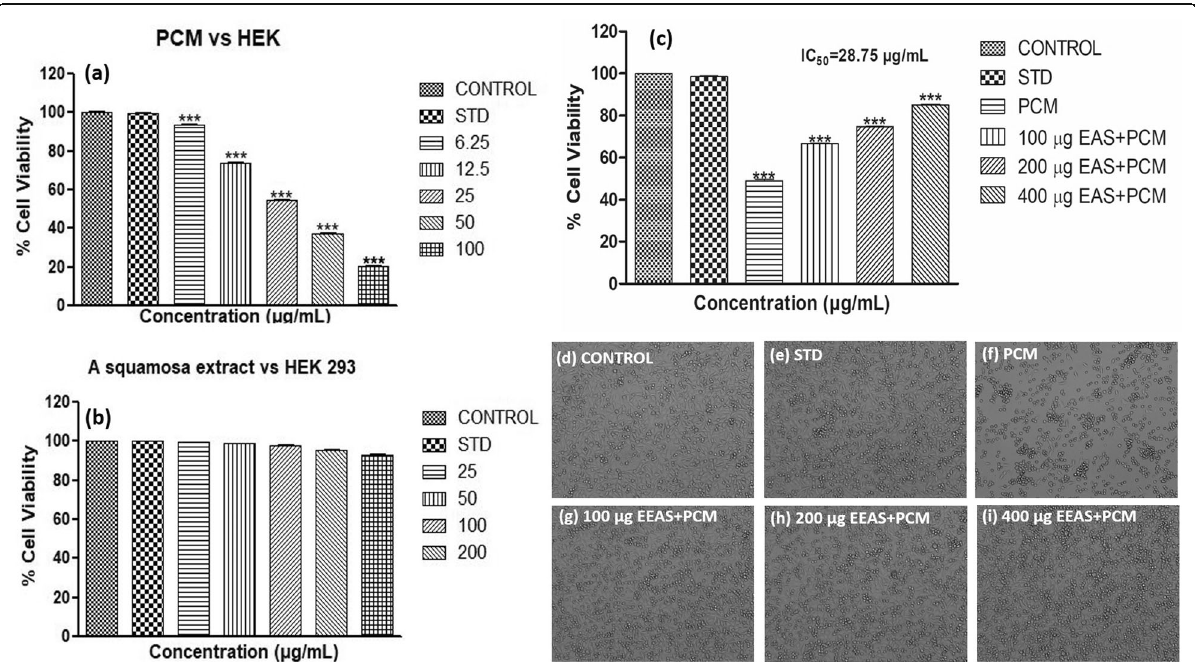
Fig. 2 Cytotoxic study for PCM and EEAS against HEK 293 cell lines ( a and b , respectively), cytoprotective study for EEAS ( c ), and direct microscopic images of cytoprotective study ( d to i)